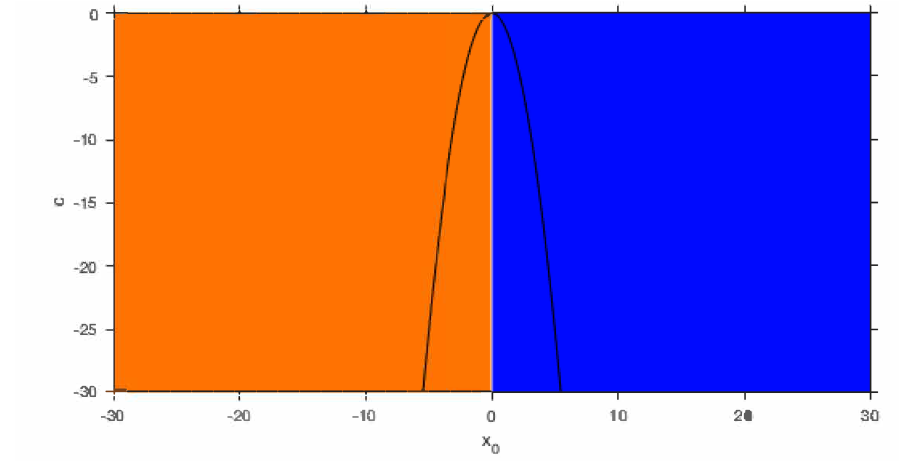
( c ) orange, x F ( c ) blue, no convergent 2 1